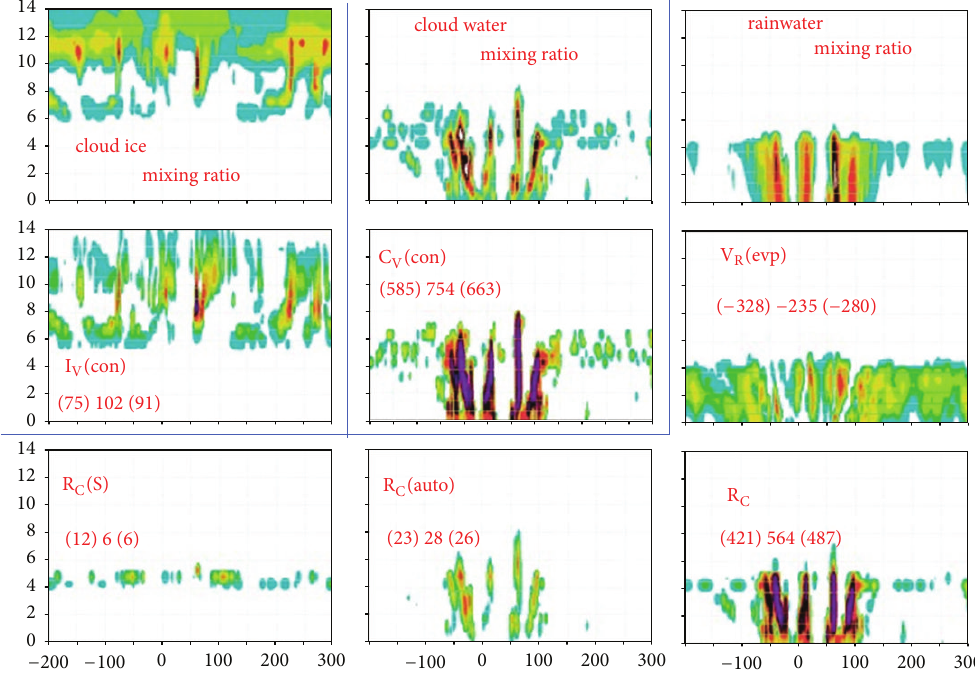
Figure 11: Same as Figure 9 but for cloud ice, cloud water, and